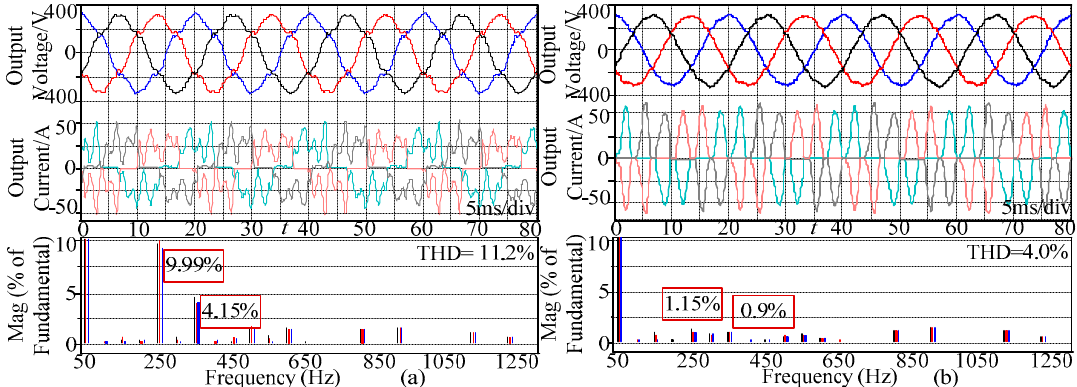
Figure 18. Voltage and current waveforms with non-linear load. ( a ) Without resonant controller; ( b ) With resonant controller.